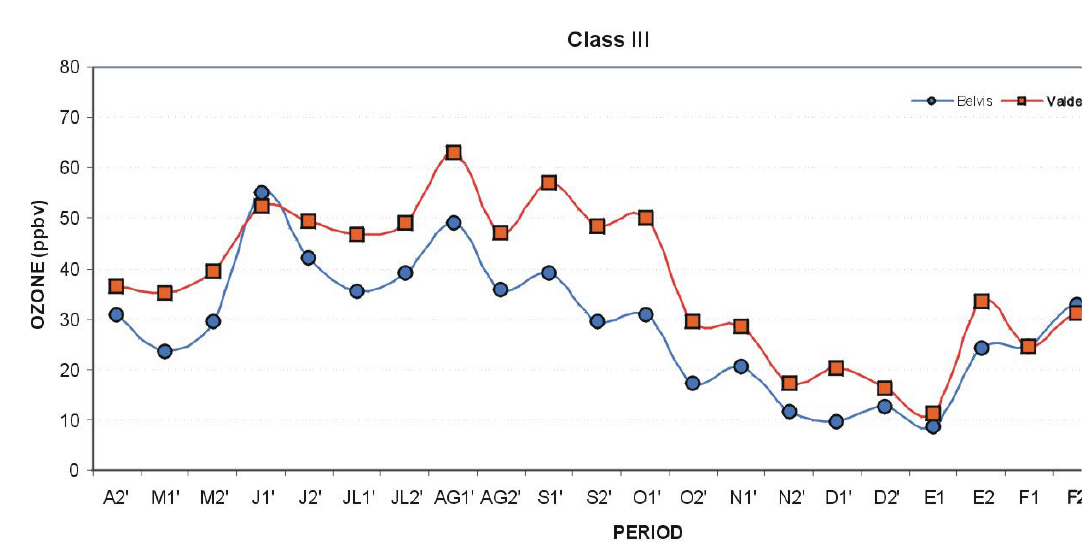
FIGURE 5. Ozone 2-week averages (ppbv) for all the Class III locations from mid-April 2000 (April 2) to end of March 2001 (March 2).